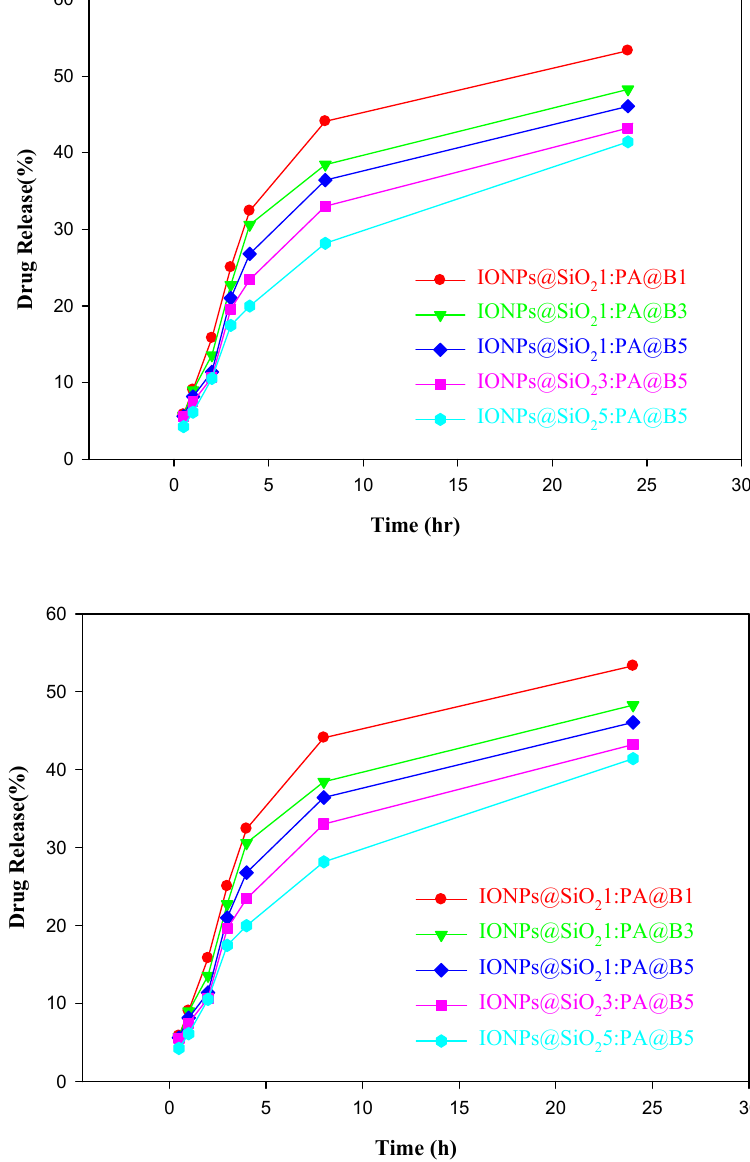
Figure 11. Controlled release study of drugs from the fabricated MCM-PA@B: aprepitant ( upper ); sofosbuvir ( lower ).